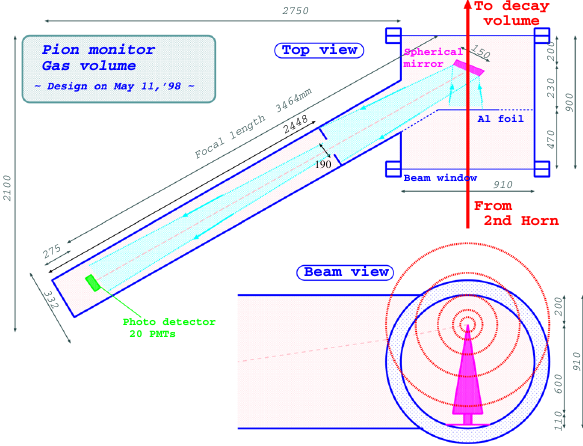
Fig. 16 A schematic view of the pion monitor (PIMON). PIMON consists of a gas vessel, a spherical mirror, and an array of 20 photo- multiplier tubes. The gas vessel is filled with freon gas R-318 (C 4 F 8 ). A pie-shaped spherical mirror is set inside the gas vessel and Cherenkov right reflected by the mirror is directed to the array of photo-multiplier tubes which are set on the focal plane of the spherical mirror